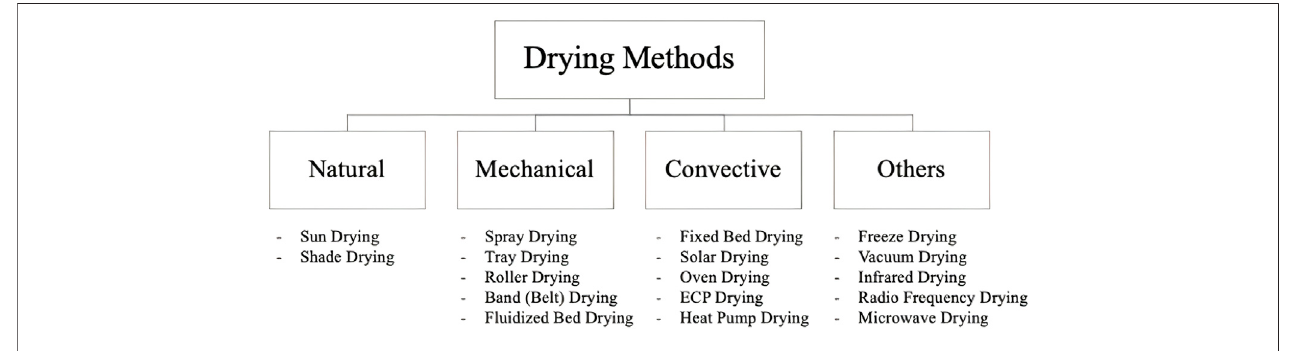
FIGURE 1 | Drying